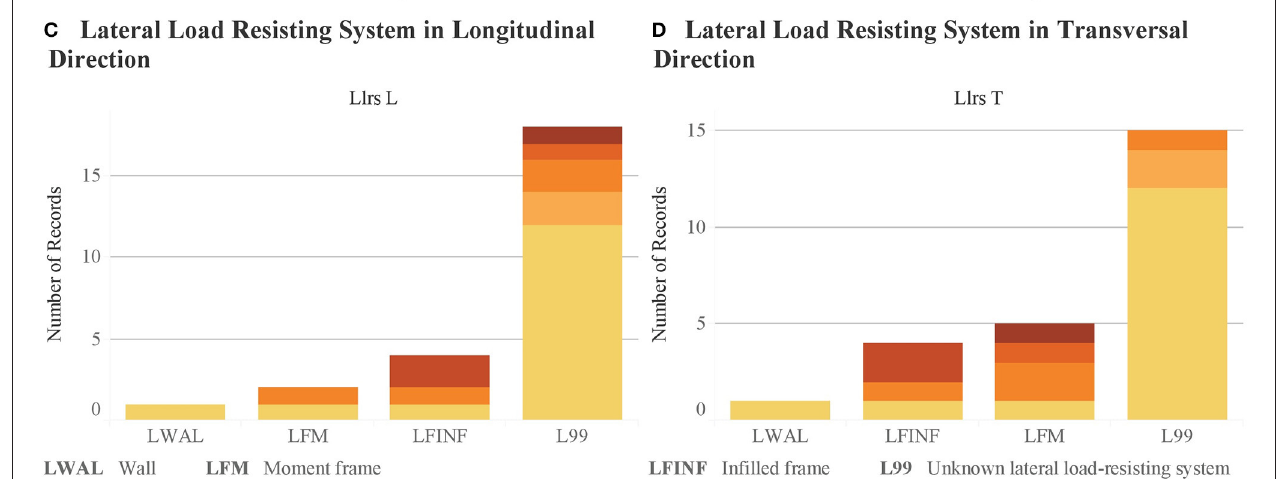
Frontiers in Built Environment |